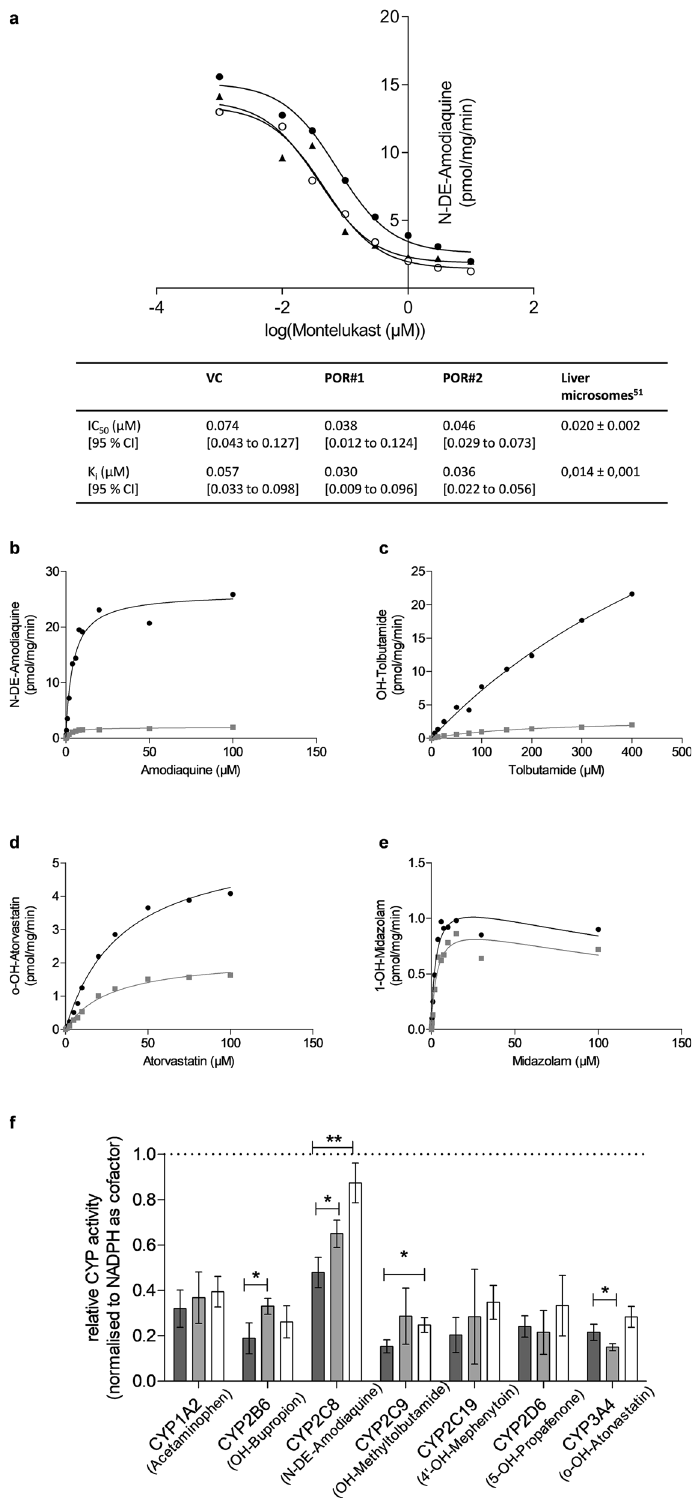
Figure 4. In depth analysis of CYP2C8-mediated amodiaquine N-deethylation. ( a ) Inhibition of amodiaquine N-deethylation with montelukast in microsomal protein. HepaRG cells transduced with vector control (VC, filled circle), sgRNAs POR#1 (filled triangle) and POR#2 (open circle) were differentiated for 3 weeks and harvested for microsome preparation. Inhibition parameters IC 50 and K i were determined by one site competition model. ( b – e ) Kinetic analysis of selected substrate conversions in bactosomes containing recombinant CYP enzymes coexpressed with high (filled circle) or low levels filled square) of POR: ( b ) amodiaquine (CYP2C8); ( c ) tolbutamide (CYP2C9); ( d ) atorvastatin (CYP3A4); ( e ) midazolam (CYP3A4). Data were analyzed by Michaelis–Menten model ( b – d ) or by substrate inhibition model ( e ). ( f ) Relative CYP-activities in microsomal preparations of differentiated HepaRG cells transduced with VC (dark grey), sgRNA POR#1 (light grey) and POR#2 (white) with either NADPH (set to 1.0) or NADH as cofactors. Results are means ± SD of 4 independent experiments. Statistical significance was assessed by unpaired t-test (* p < 0.05, ** p <